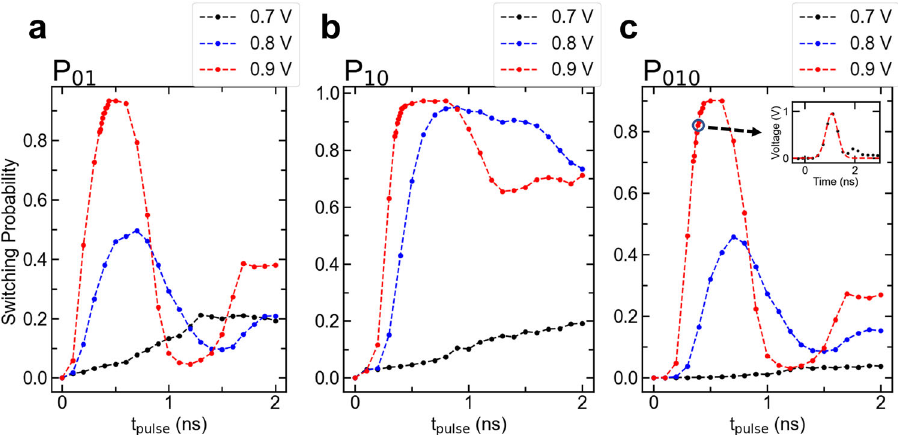
Fig. 3 Measured switching probabilities for a 70 nm device. Switching probabilities a from parallel to antiparallel (P 01 ), b antiparallel to parallel (P 10 ), and c back and forth switching (P 010 ) under different voltage pulses, as a function of pulse duration. The inset in c shows the measured shape of the pulse with 0.9 V nominal amplitude and 0.4 ns width, which gives >90% switching probability in both directions. The black dots are measured using an oscilloscope with a 1 M Ω impedance, and the red dashed line is a Gaussian fi t to